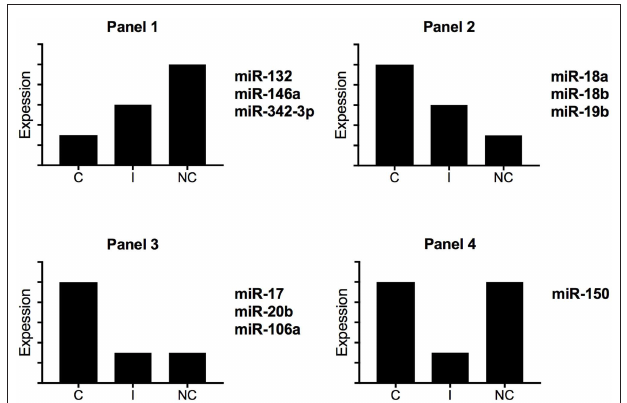
FIGURE 3 | Schematic representation of miRNA expression profiles for human monocyte subsets. By using miRNome data from the study of Zawada et al. (22), we identified four different expression profiles. C, classical monocytes CD14 ++ CD16 − ; I, intermediate monocytes CD14 ++ CD16 + ; NC, non-classical monocytes CD14 + CD16 ++ .